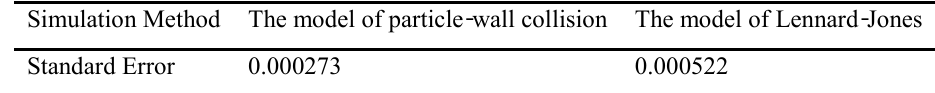
The standard errors of velocity